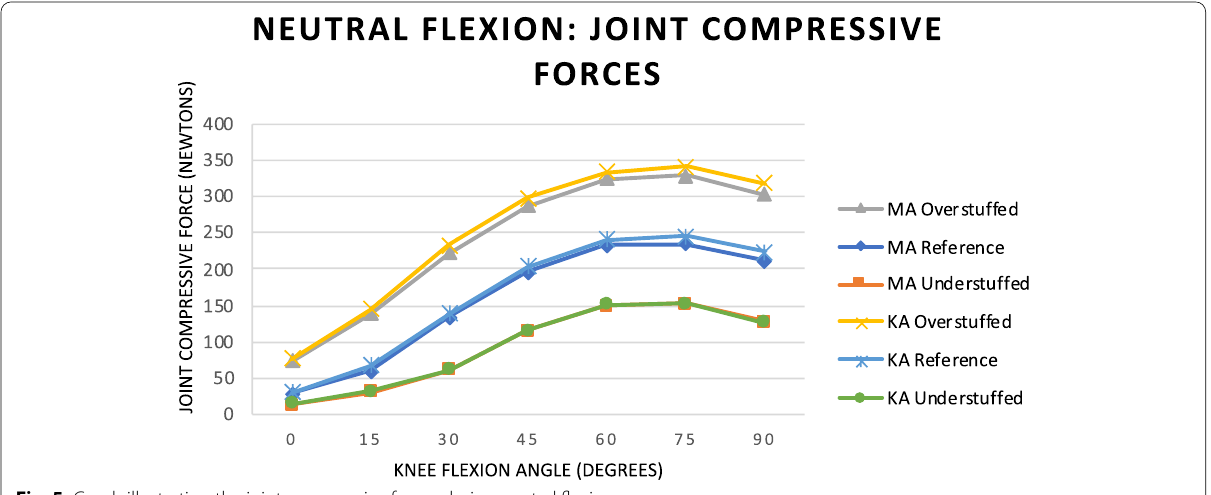
Fig. 5 Graph illustrating the joint compressive forces during neutral